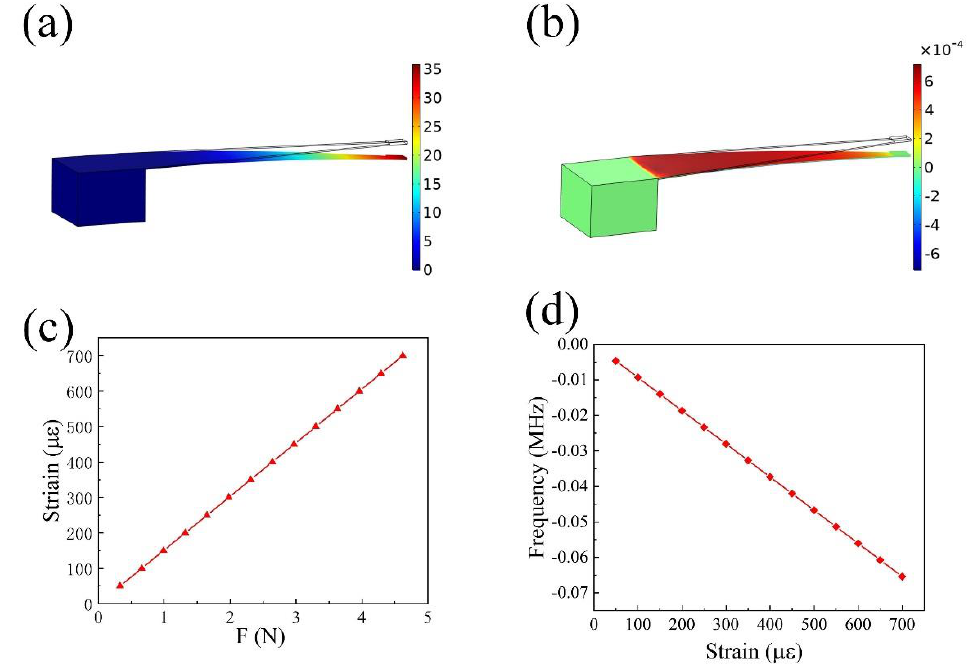
Figure 2. The strain test platform was simulated and designed. ( a , b ) Strain and displacement distribution of cantilever beam under 4.62 N pressure. ( c ) The relationship between the pressure loaded on the cantilever beam and the strain at the position of the strain sensor. ( d ) The relationship between the strain loaded on the sensor and the frequency shift of the strain